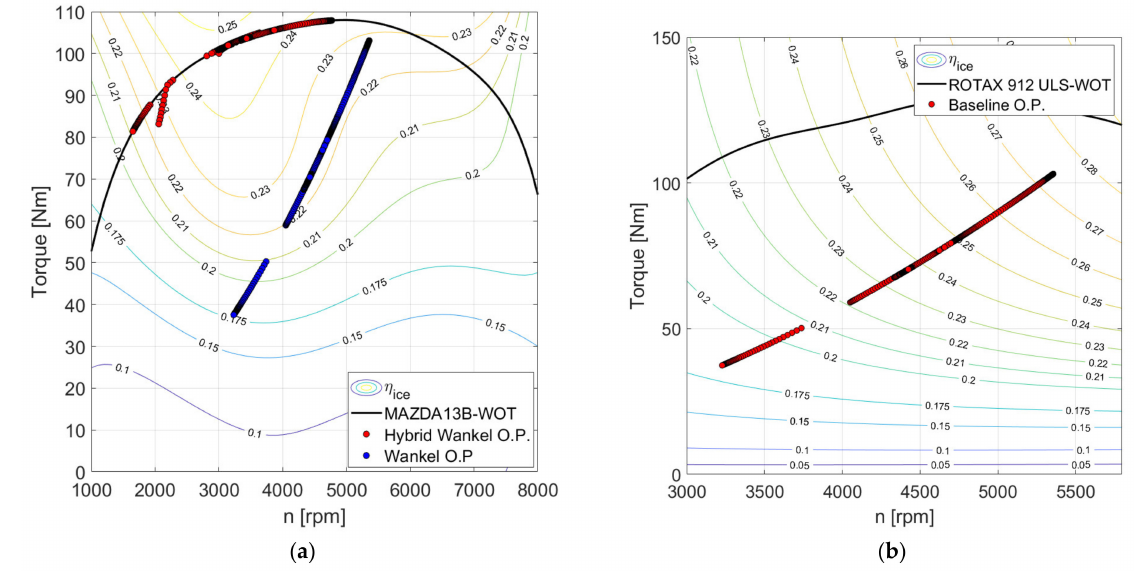
Figure 15. Operating points (O.P.) of the two engines in the three configurations ( a ) engine one; ( b ) engine two.